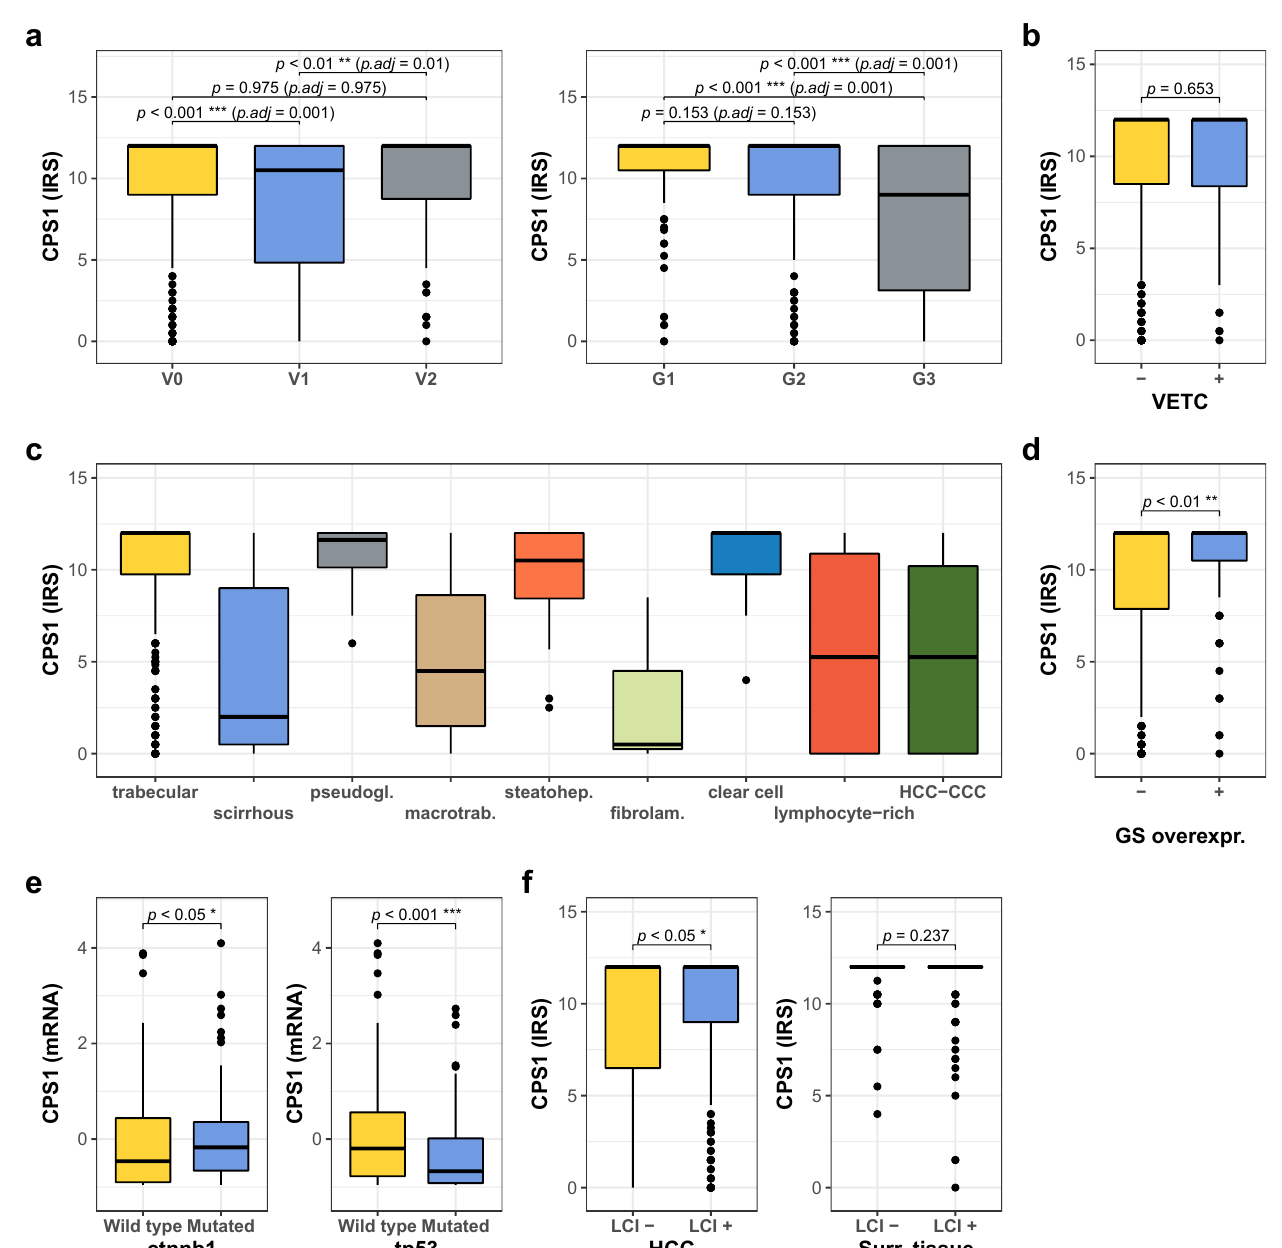
Figure 4. Comparison of CPS1 expression with clinicopathological and molecular parameters. ( a ) Quantification of CPS1 expression detected by immunohistochemistry with respect to vascular invasion (left panel, V0: n = 347, V1: n = 109, V2: n = 80) and tumor grade (right panel, G1: n = 100, G2: n = 266, G3: n = 115). ( b ) Quantification of CPS1 expression in relation to absence or presence of the VETC pattern (VETC-: n = 440, VETC+: n = 95). ( c ) Quantification of CPS1 expression according to morphological tumor subtype (patient numbers: trabecular: 419, scirrhous: 5, pseudogl.: 18, macrotrab.: 40, steatohep.: 22, fibrolam.: 3, clear cell: 7, lymphocyte-rich: 4, HCC-CCC: 9. ( d ) CPS1 expression levels in relation to absence or presence of GS overexpression as a marker for CTNNB1 mutations/activated WNT signaling (GS neg.: n = 423, pos: n = 110). ( e ) Quantification of CPS1 mRNA in the TCGA cohort with respect to mutational status to CTNNB1 (left panel, wild type: n = 264, mutated: n = 96) and TP53 (right panel, wildtype: n = 249, mutated 111). ( f ) Quantitative analysis of CPS1 expression in tumor tissue (left panel, no cirrhosis: n = 193, cirrhosis: n = 343) and in the surrounding liver tissue (right panel, no cirrhosis: n = 187, cirrhosis: n = 346) with respect to absence of presence of liver cirrhosis). For all analyses * denotes p ≤ 0.05, ** p ≤ 0.01, *** p ≤